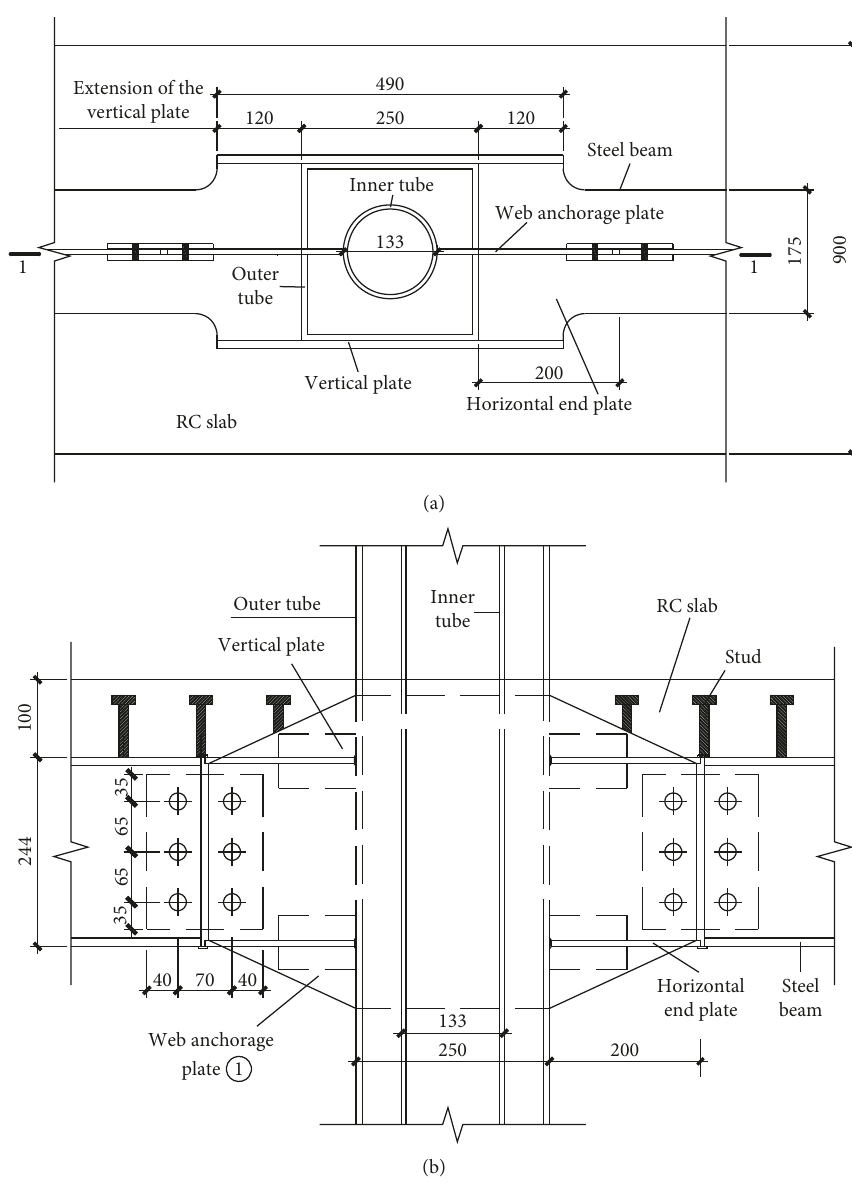
Figure 2: Details of the composite joint CBJ4: (a) plan view; (b) cutaway view of